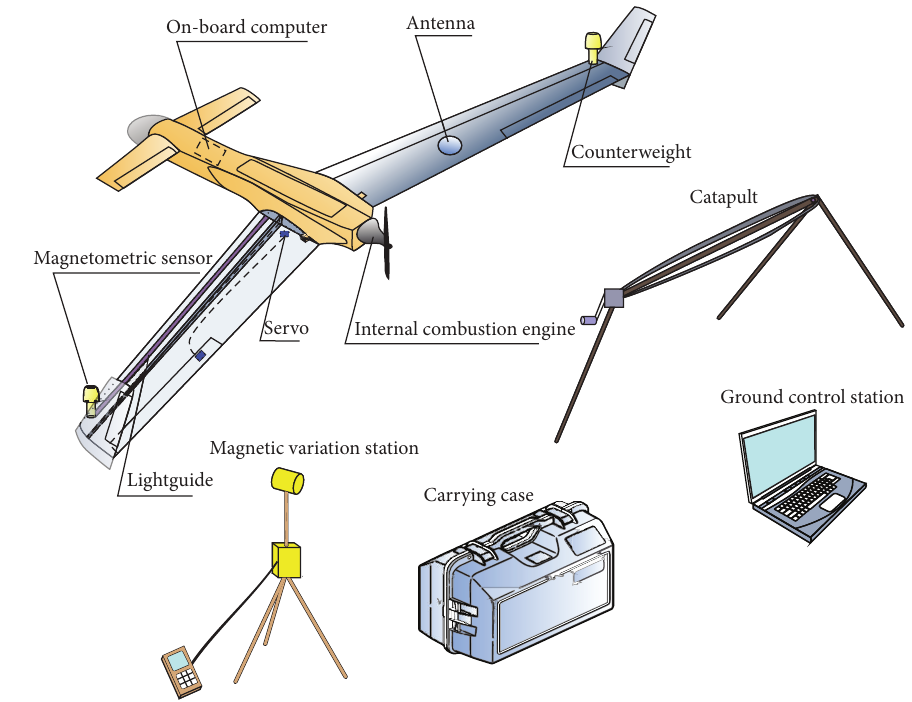
Figure 8: The concept of the NUAP.